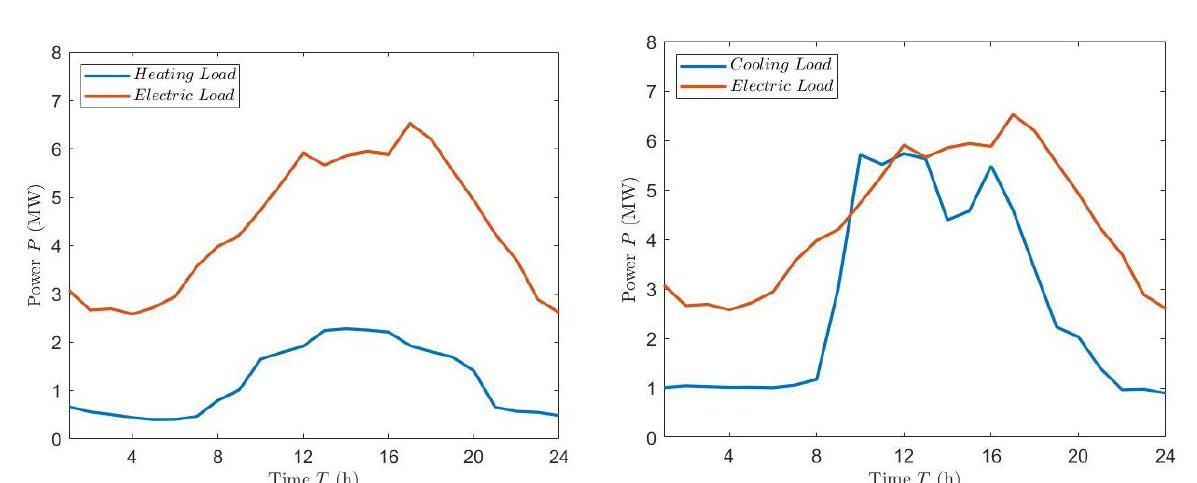
Figure 4. Load prediction